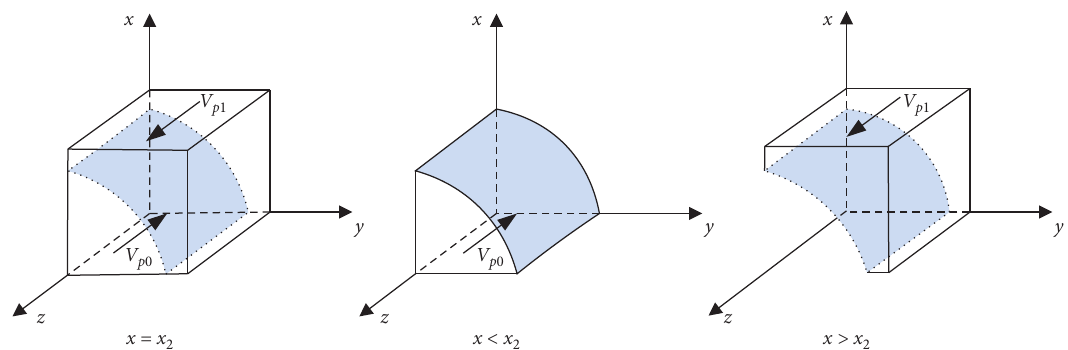
Figure 4: Phase diagram of the third-party testing agencies’ strategic